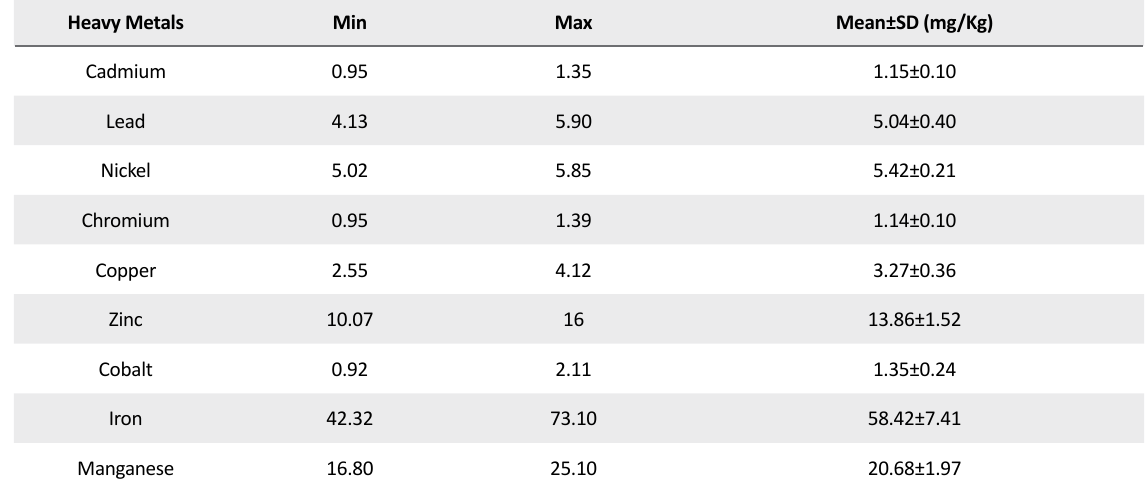
Table 3. Statistical parameters of heavy metals in wheat of agricultural fields in Assad